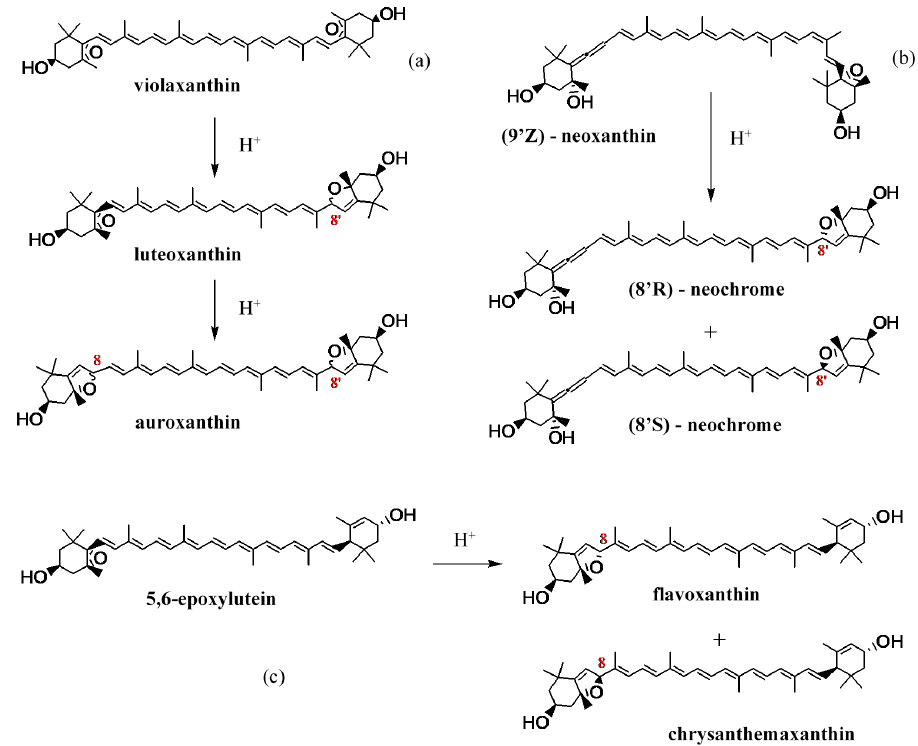
Figure 2. Acid-catalyzed isomerization of ( a ) violaxanthin, ( b ) (9 ′ Z)-neoxanthin, and ( c ) 5,6- epoxylutein.